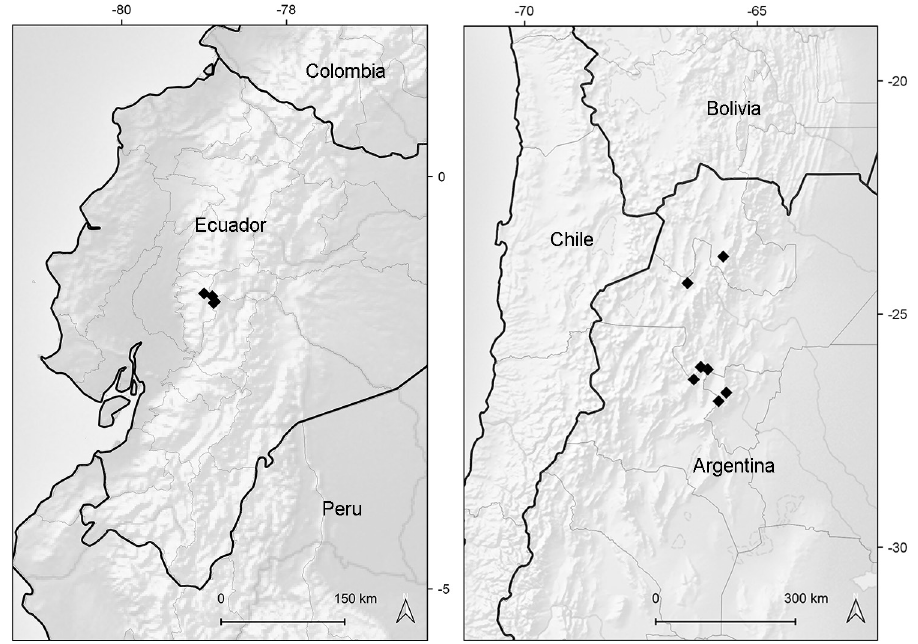
Figure 3. Distribution map of Xenophyllum funkianum (left hand) and X. lorochaqui (right hand).